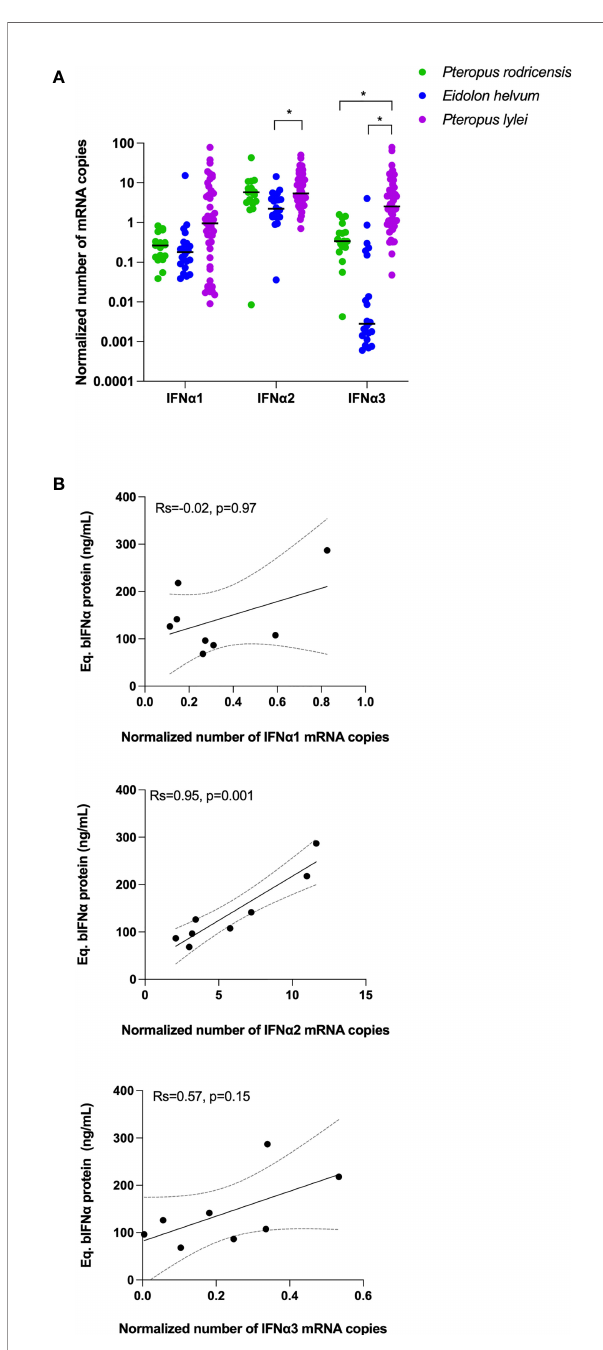
FIGURE 3 | IFN a mRNA levels in bats and mRNA-protein correlations. (A) Number of copies measured in whole blood for IFN a 1, IFN a 2 and IFN a 3 mRNAs as normalized to GAPDH in three bat species. Probes used here were not suitable for Rousettus aegyptiacus . Median represented by black line with individual animals shown by colour coded dots. Kruskal – Wallis test with Dunn ’ s post testing for multiple comparisons was used. *p<0.05. (B) Correlation plots between the Eq. bIFN a protein concentration obtained using the hIFN a 2 digital ELISA assay and the GAPDH-normalized number of IFN a 1, IFN a 2 and IFN a 3 mRNA copies. Spearman method is used for correlation analysis with Spearman ’ s Rank Correlation Coef fi cient R (Rs) and p values reported